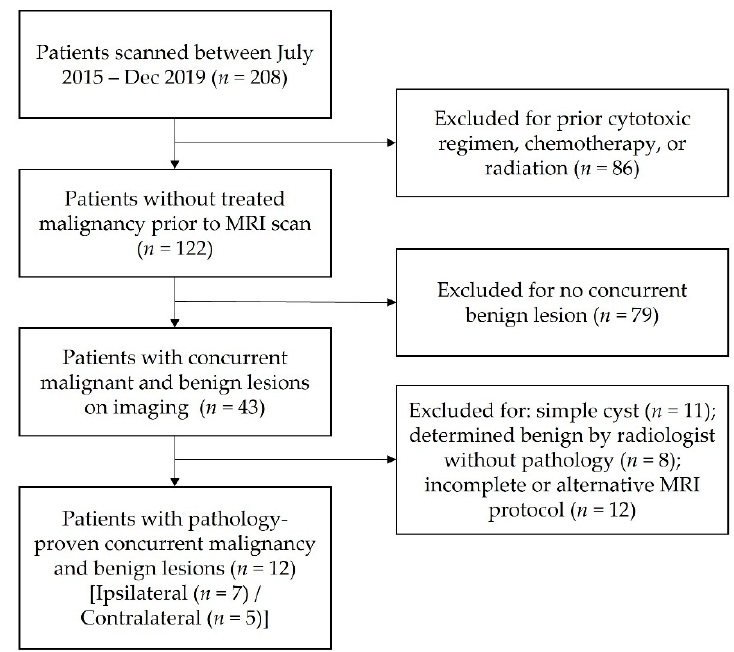
Figure 1. Patient selection flow chart.